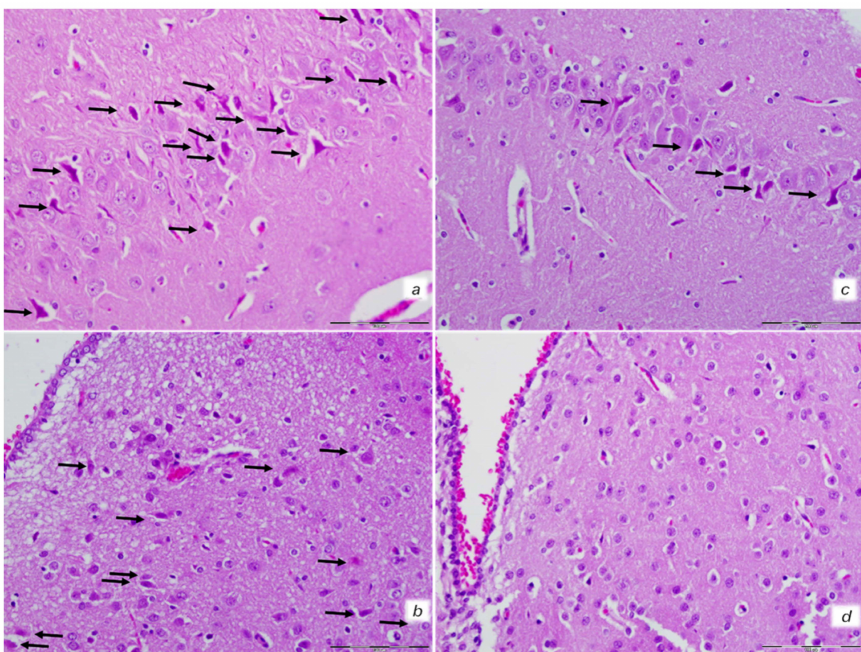
Figure 9. Neuropathological features of the hippocampus and hypothalamus. Isoprenaline 75 mg/kg at 30 min after challenge. Control rats ( a , b ). ( a ) Marked karyopyknosis of pyramidal cells of the hippocampus (black arrows). ( b ) Rare karyopyknotic cells in hypothalamic area. BPC 157-treated rats ( c , d ). ( c ) Small number karyopyknosis of pyramidal cells of the hippocampus. ( d ) No changes in hipothalamic area. (HE staining; magnification 400 × ; scale bar 100 µ